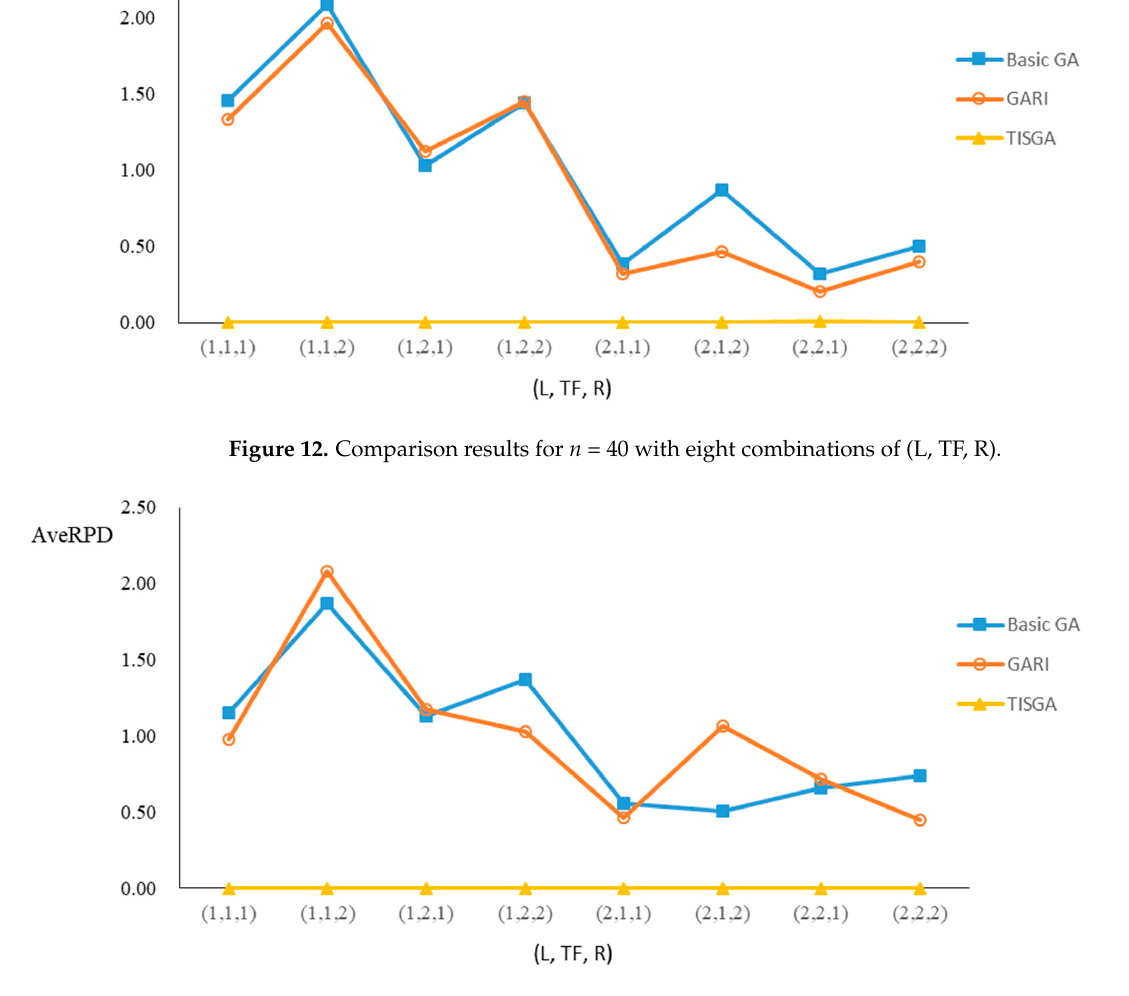
19 of 31 Figure 10. Comparison results for n = 30 with eight combinations of (L, TF, R).